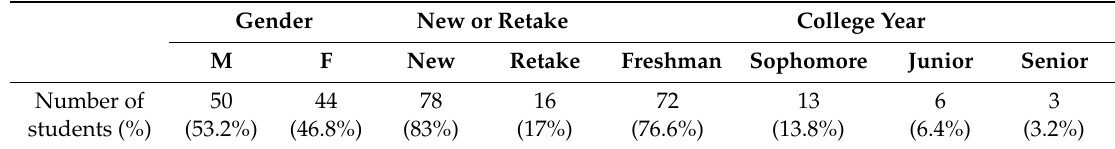
Table 2. Sample distribution ( n = 94). M—male; F—female.